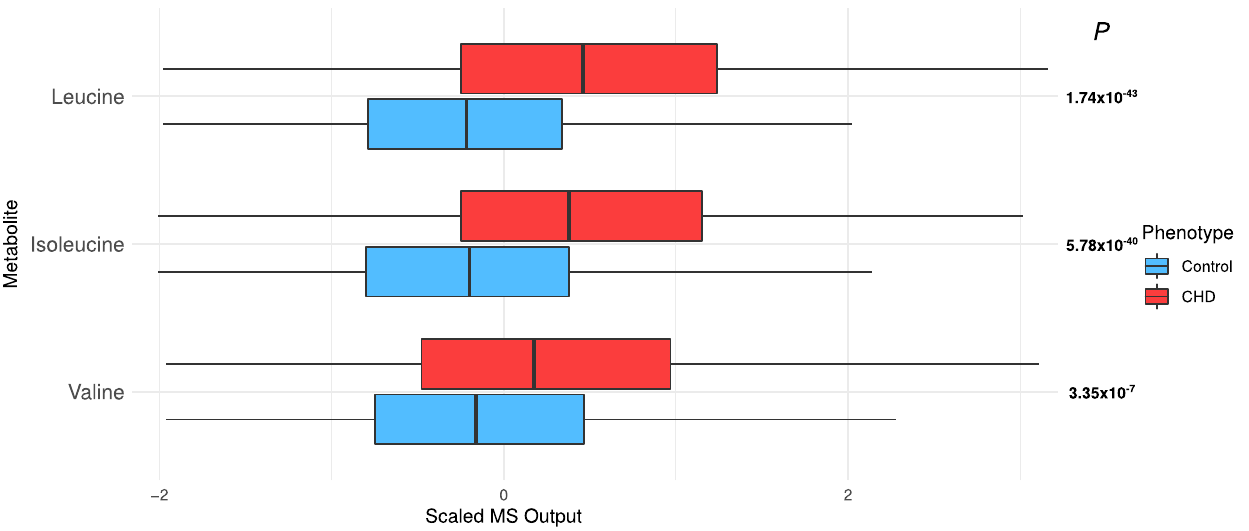
Elevated branched chain amino acids (BCAAs) : BCAAs, i.e., leucine, isoleucine, and va- line, were significantly elevated in the CHD patients (leucine, p = 1.74 × 10 − 43 ; isoleucine, p Figure 4. The distribution of long-chain chain fatty acids in the CHD patients and the controls. = 5.78 × 10 − 40 ; and valine, p = 3.35 × 10 − 7 ; Figure 5).